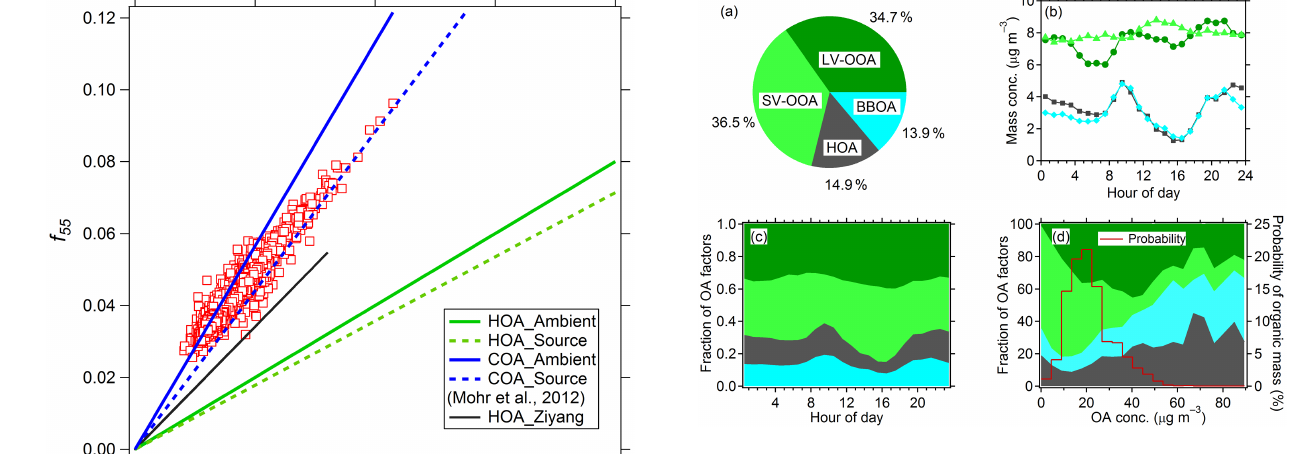
Figure 8. (a) Average mass fraction of each OA component. Diurnal variations of concentrations (b) and fractions in OA (c) for differ- ent OA components. (d) Fractions of different OA components in total OA (left) depending on OA concentrations and the probability density of OA concentrations